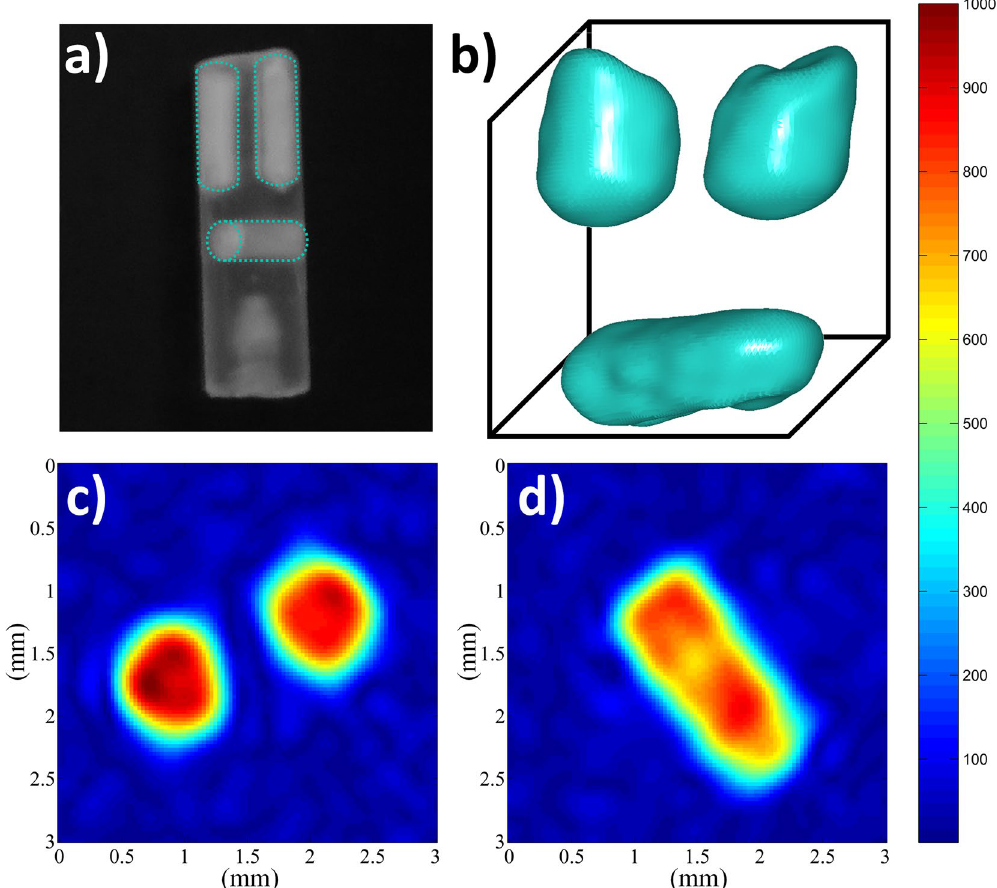
Figure 2. ( a ) Picture of the phantom made of a PCTFE (Kel-F) insert with two boreholes parallel and one perpendicular to the spinning axis (1 mm in diameter) filled with the CDA powder. ( b ) Isosurface representation of the 31 P 3D MAS image of the phantom recorded at 17.6 T with a spinning frequency of 10 kHz using the spin echo sequence shown in Fig. 3a. The isosurface value is 40% of the maximum signal intensity. 1 H- 31 P cross polarization with a contact time of 3 ms was used and 80 transients were co-added with a recycle delay of 0.5 s corresponding to an experimental duration of 11 h 32 min. The nominal resolution is 132 µ m in the read dimension (corresponding to a gradient of 15.47 G/cm) and 155 µ m in the phase dimensions with a field of view of 7.5 * 7.5 * 15 mm. SNR = 103. The dataset was zero-filled three times leading to voxel size of 30 × 30 × 30 µ m 3 . ( c , d ) 31 P 2D slice-selected MAS images of the CDA phantom taken at ( c ) the top and d) the middle part of the sample. A refocusing-SNOB pulse of 900 µ s duration (excitation bandwidth of 2.6 kHz) was used to select a slice of 710 µ m thickness. The spatial resolution is 117 µ m in read dimension (gradient of 17.44 G/cm) and 155 µ m in phase dimension, corresponding to an experimental time of 17 min. SNR = 60 and pixel size of 30 × 30 µ m 2 after zero-filling of the dataset. The color bar scales from zero up to the maximum signal